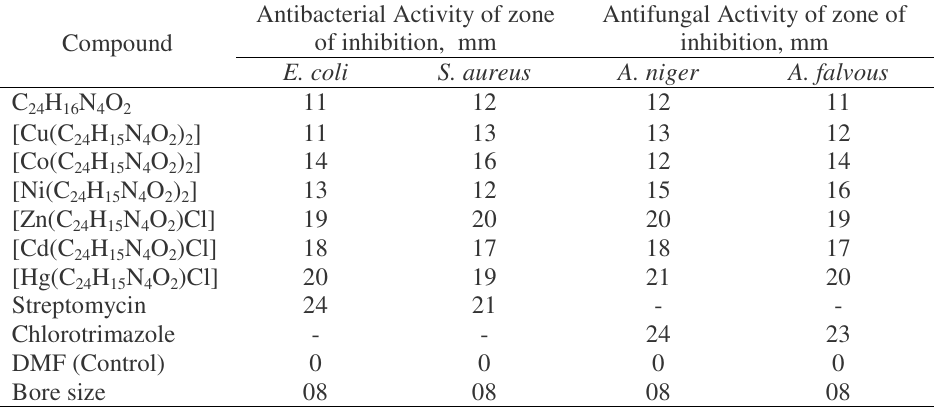
Table 5 . Antimicrobial activity of the ligand [HQMAPQ] and its metal(II) complexes Antibacterial Activity of zone Antifungal Activity of zone of of inhibition, mm inhibition, mm Compound E. coli S. aureus A. niger A. falvous